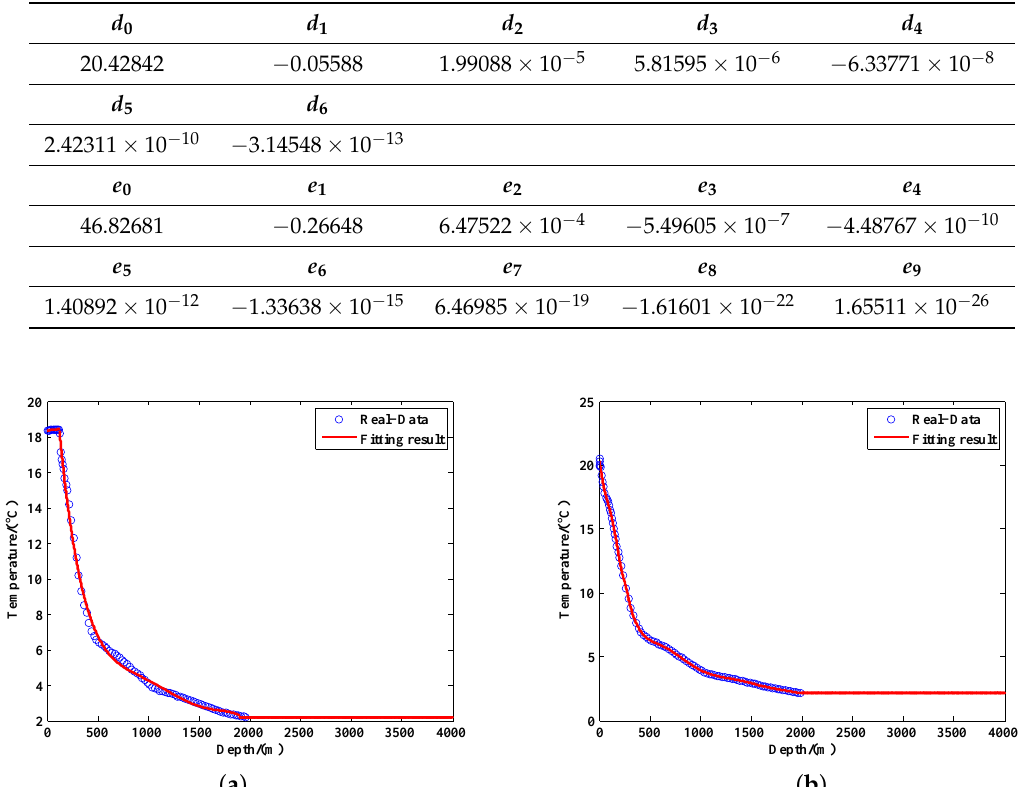
Table 4. The coefficient values for polynomial fitting of T h _ sw .